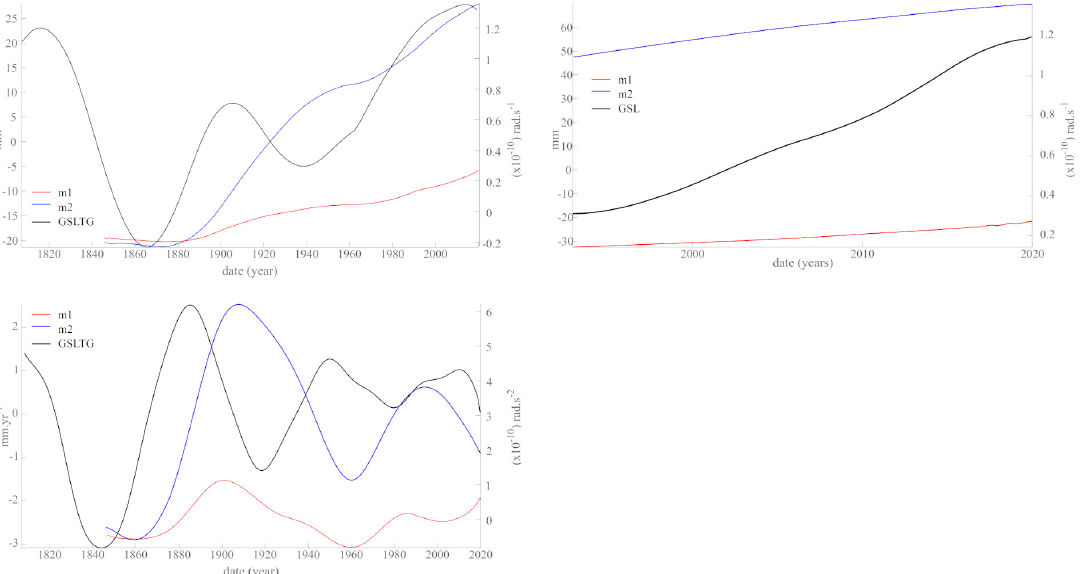
Figure 13. Trends ( top ) and their derivatives ( bottom ) of the rotation pole ( RP ) coordinates m 1 (red) and m 2 (blue) compared with those for GSLTG ( left ;